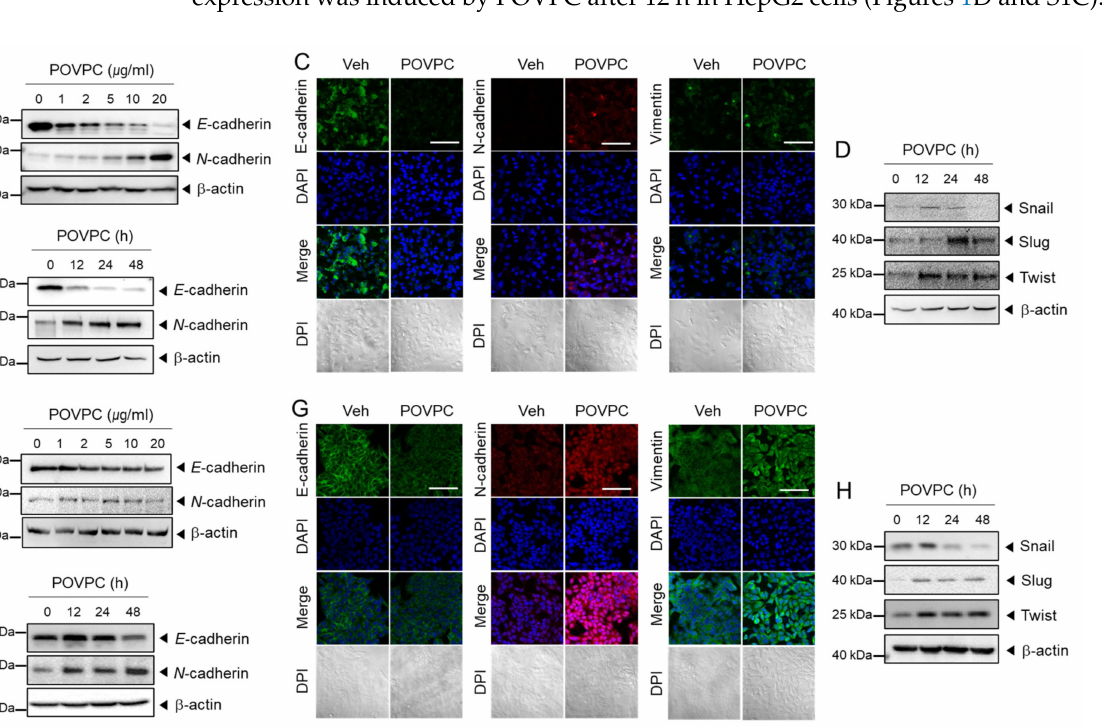
Figure 1. 1-palmitoyl-2-(5-oxovaleroyl)- sn -glycero-3-phosphocholine (POVPC) induces changes in epithelial-mesenchymal transition marker expression in cancer cells. ( A , B ) HepG2 cells were treated with ( A ) the specified doses of POVPC for 48 h and ( B ) 5 µ g/mL of POVPC for the indicated periods. The levels of EMT-related protein markers were determined by immunoblotting with β -actin as the loading control. ( C ) HepG2 cells were treated with 5 µ g/mL of POVPC for 48 h. Expres- sion of E -cadherin (green), N -cadherin (red), and vimentin (green) was determined using confocal immunofluorescence microscopy. Cells were identified by DAPI staining of the nuclei (blue). The scale bar represents 100 µ m. ( D ) HepG2 cells were treated with 5 µ g/mL of POVPC for the indicated periods. The levels of transcription factors (Snail, Slug, and Twist) were determined by immunoblotting with β -actin as the loading control. ( E , F ) MCF7 cells were treated with ( E ) the specified doses of POVPC for 48 h and ( F ) 5 µ g/mL of POVPC for the indicated periods. The protein levels of EMT-related markers were determined by immunoblotting with β -actin as the loading control. ( G ) MCF7 cells were treated with 5 µ g/mL of POVPC for 48 h and processed as described in C. ( H ) MCF7 cells were treated with 5 µ g/mL of POVPC for the indicated periods and processed as described in ( D